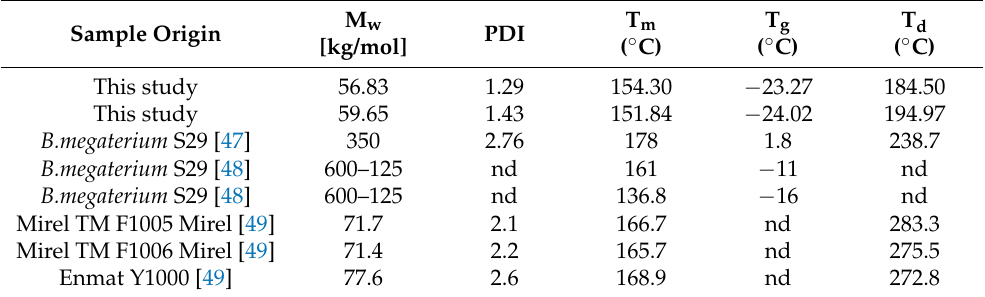
Table 1. Material properties produced by the same strain in different studies in comparison with commercially available products.